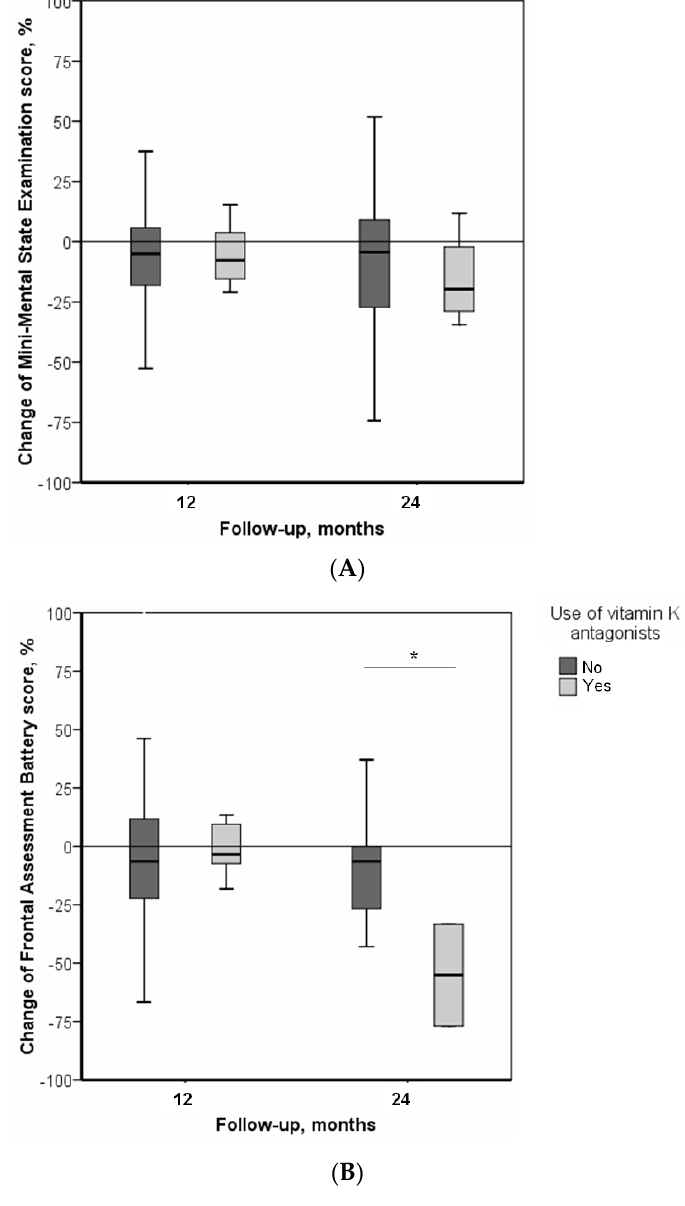
Figure 1. Changes in cognitive scores during follow-up, according to use of vitamin K antagonists † . ( A ) Changes in Mini-Mental State Examination scores. ( B ) Changes in Frontal Assessment Battery scores during follow-up. *: p = 0.023 (two-tailed). † : n = 170 followed-up at 12 months; n = 58 followed-up at 24 months.